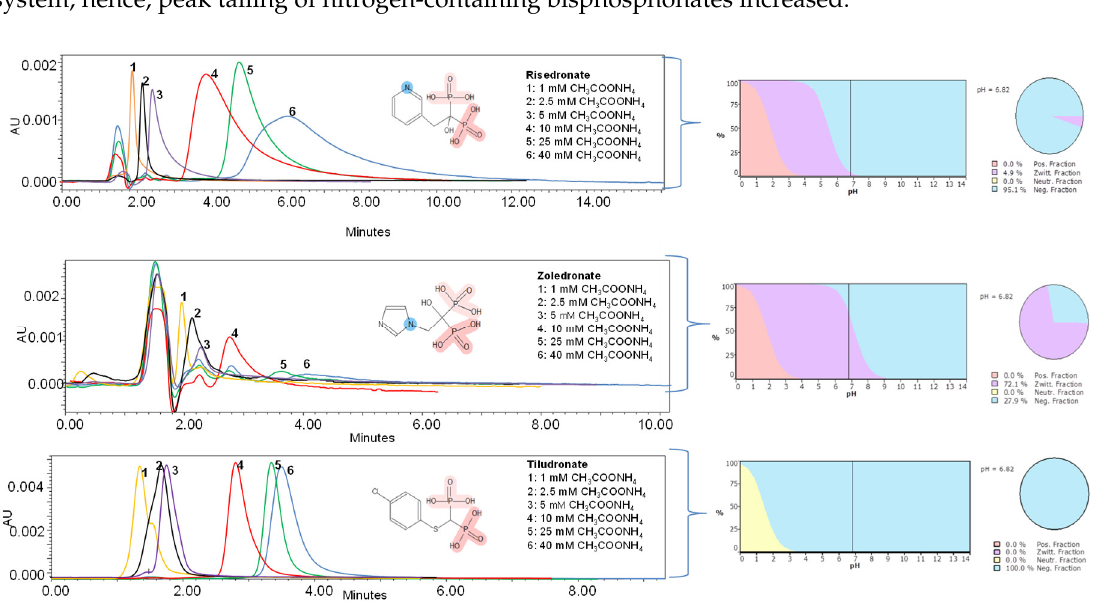
Figure 1. Typical HILIC chromatograms displaying the effect of ammonium acetate concentration on the peak shape and the retention of bisphosphonates, accompanied by diagrams of their ionization state at pH 6.8 as calculated ADME boxes ver. 3.0, Pharma Algorithms software.